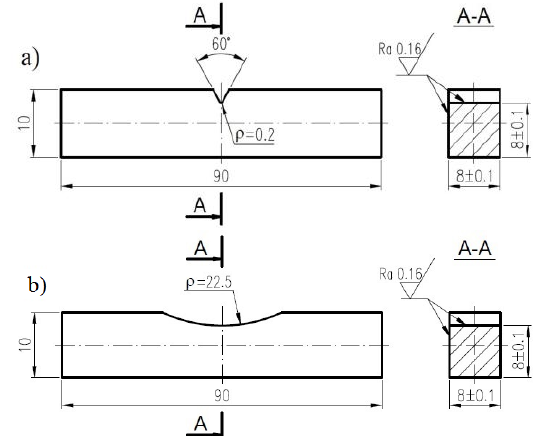
Fig. 3. Shape and dimensions of specimen for: a) ρ = 0.2 mm, b) ρ = 22.5 mm.